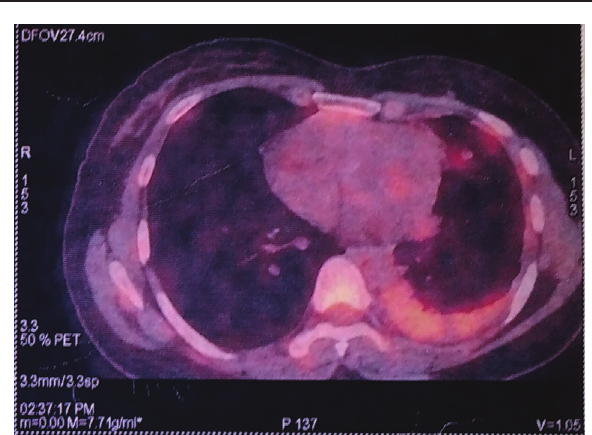
thickening of the right pleura without any fluid collection. Contrast-enhanced CT (Fig. 4) of the